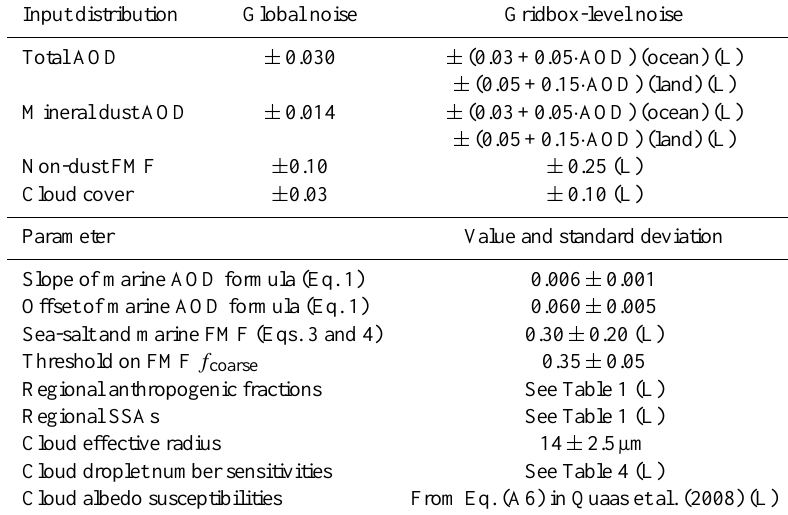
Table 5. Summary of input distributions and parameters of the algorithm used in the MACC estimates of aerosol forcing. Standard deviations used to characterise probability density functions (PDFs) in the Monte-Carlo uncertainty analysis are also shown. PDFs are normal distri- butions, except for cases marked with (L), where a log-normal distribution is used. See Sect. 7 for details. AOD stands for aerosol optical depth, FMF for fine-mode fraction, and SSA for single-scattering albedo, all taken at 0.55µm. Input